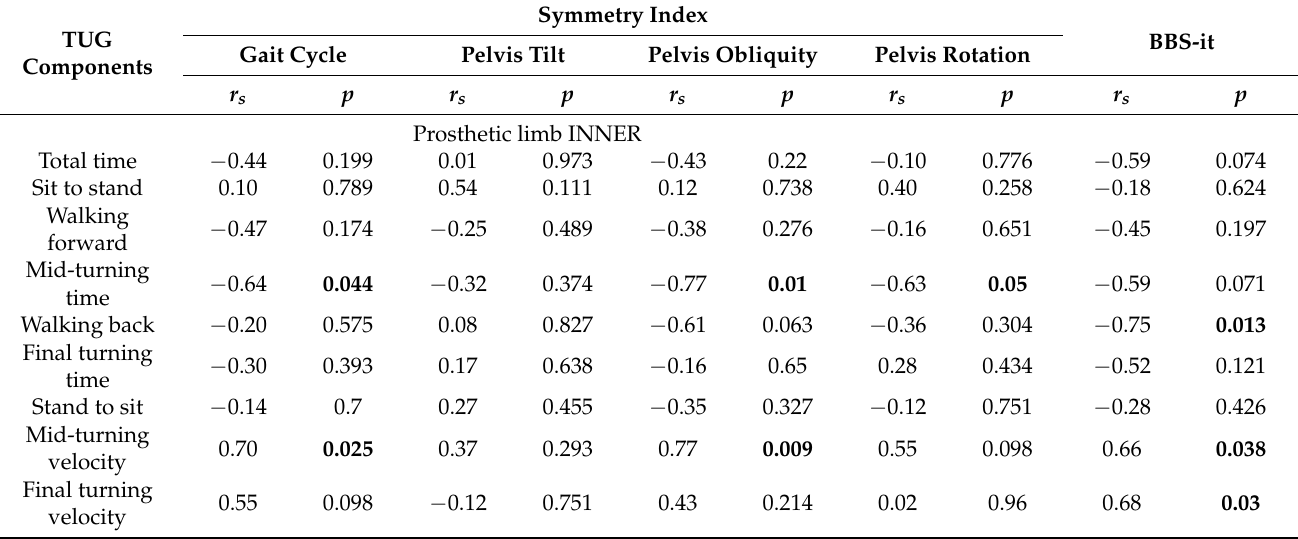
Table 5. Results of Spearman’s correlation